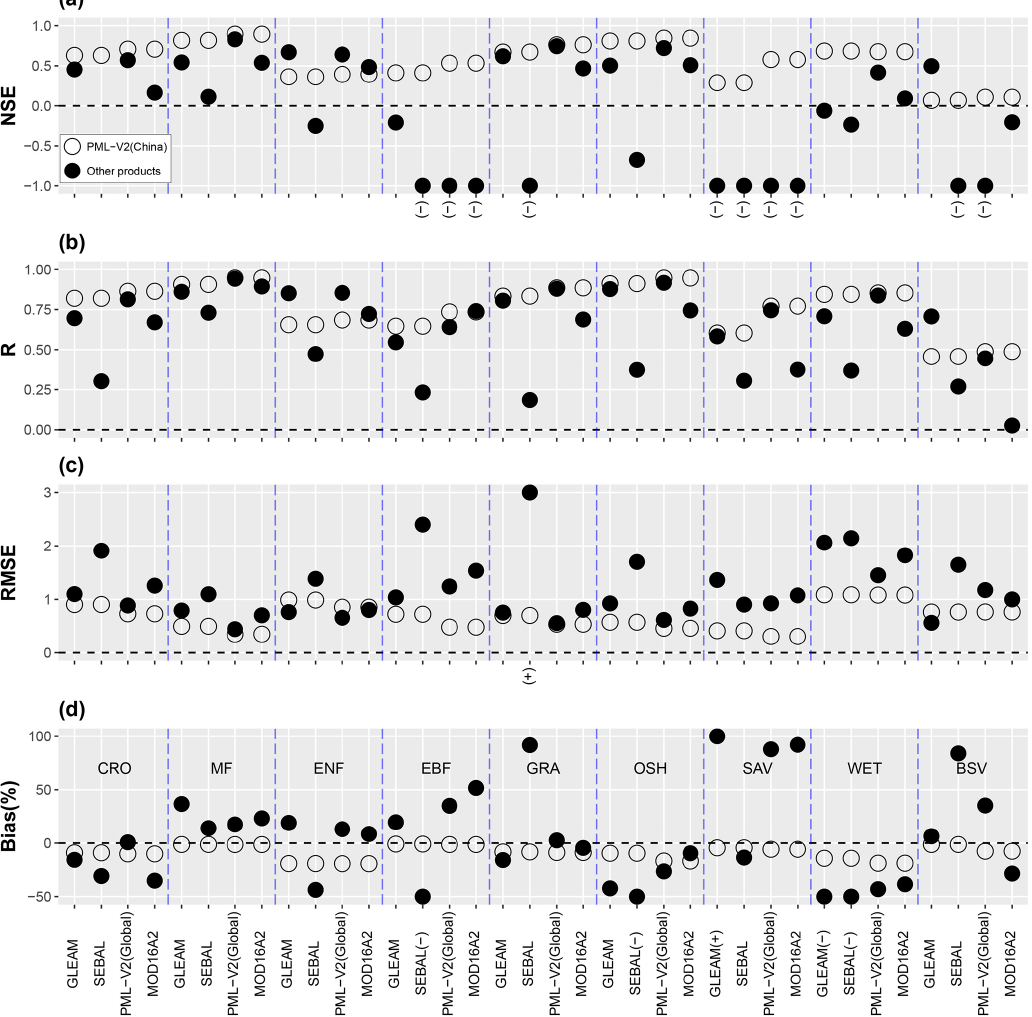
Figure 7. Statistical indicators of PML-V2(China) and other models for estimating ET at each PFT. Open and solid dots represent PML- V2(China)-estimated ET in cross-validation mode and other models. For the daily temporal resolution of GLEAM and SEBAL, PML- V2(China) is also daily scale, while for 8d resolution of PML-V2(Global) and MOD16A2, the referred PML-V2(China) is upscaled to 8d. Note that “( + )” indicates that the model’s simulation statistics dot is more than the upper bound, while “(–)” indicates that the model’s simulation statistics dot is less than the lower